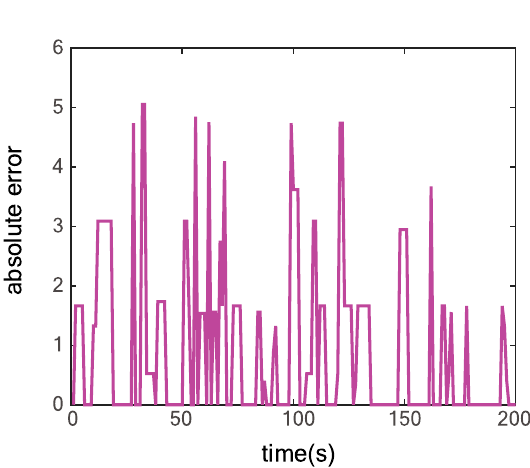
Figure 11. Curves of absolute errors.